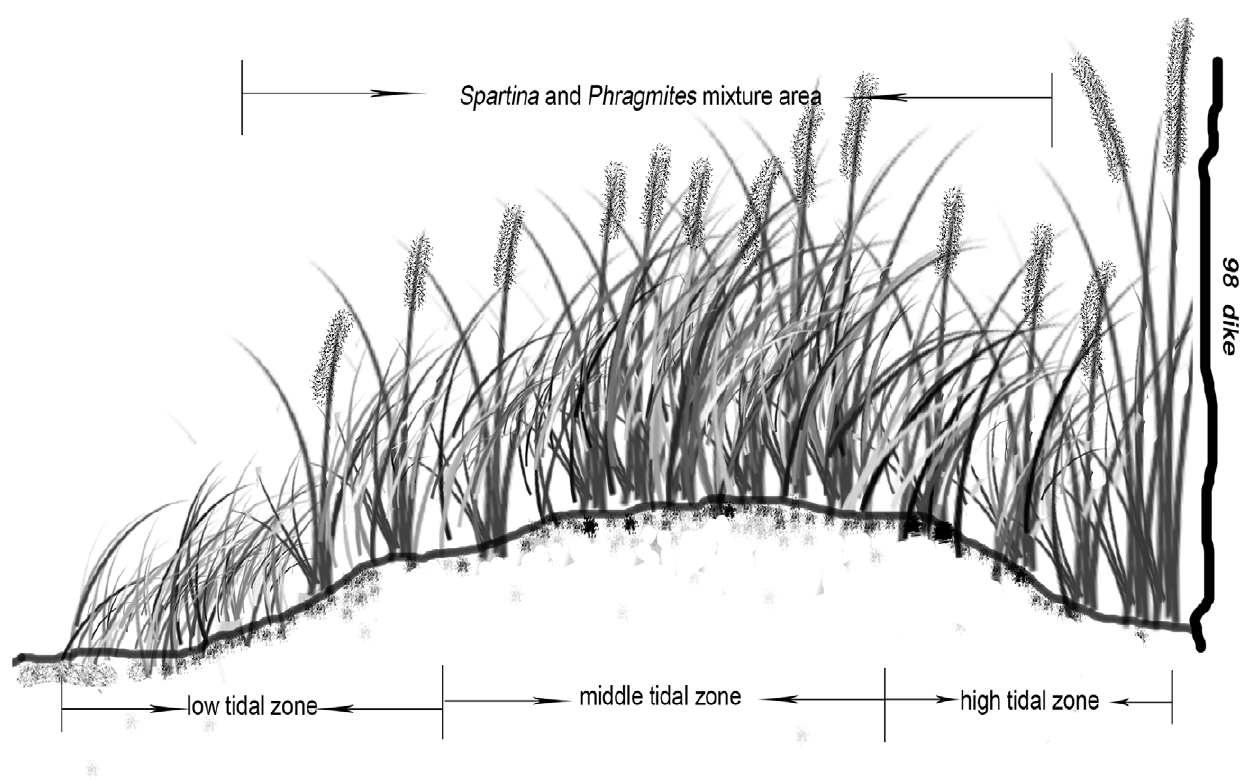
Figure 2. The distribution of P.australis and S.alterniflora in the research area along the environmental gradient.